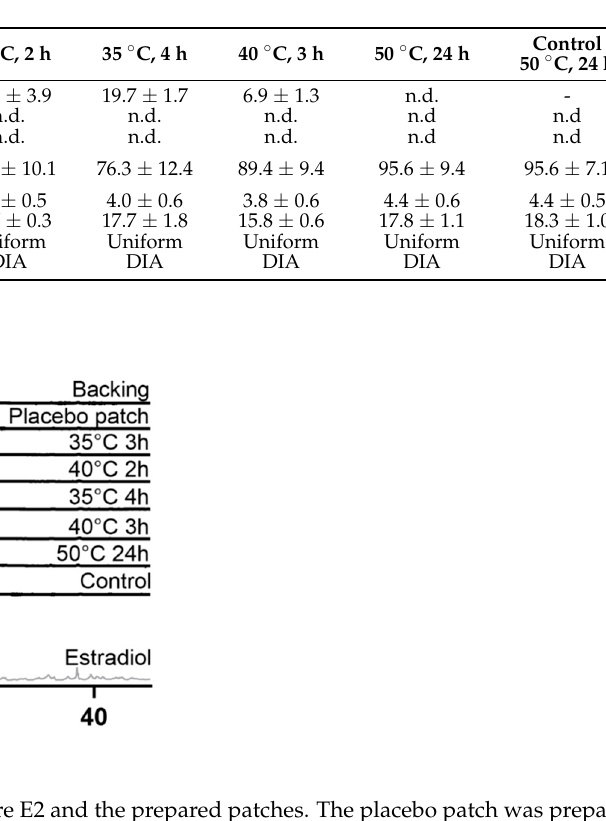
Table 1. Exemplary compositions of the adhesive mass at different production times. From an initially (t = 0 h) viscous and liquid mixture to a homogeneous drug-in-adhesive layer (per DIA). Control was prepared without dimethyl sulfoxide (DMSO) (mean ± SD; n.d. = not detected).